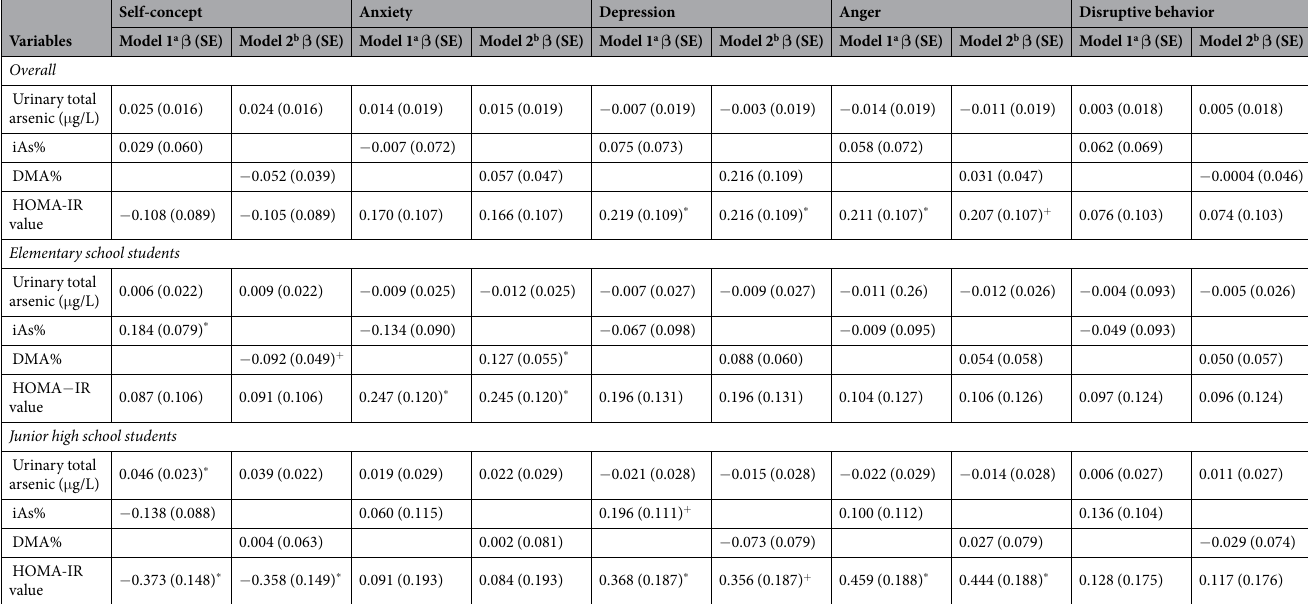
Table 5. Multiple linear regression analyses of urinary arsenic profiles, HOMA-IR values and psychological characteristics. β , regression coefficient; SE, Standard error. Multivariable linear regression analyses were adjusted for covariates, indicated age, gender, schools, father’s educational levels, mother’s educational levels. BMI, body fat, and urinary creatinine. a Model 1: Psychological scores = β 0 + β 1 ·(Urinary